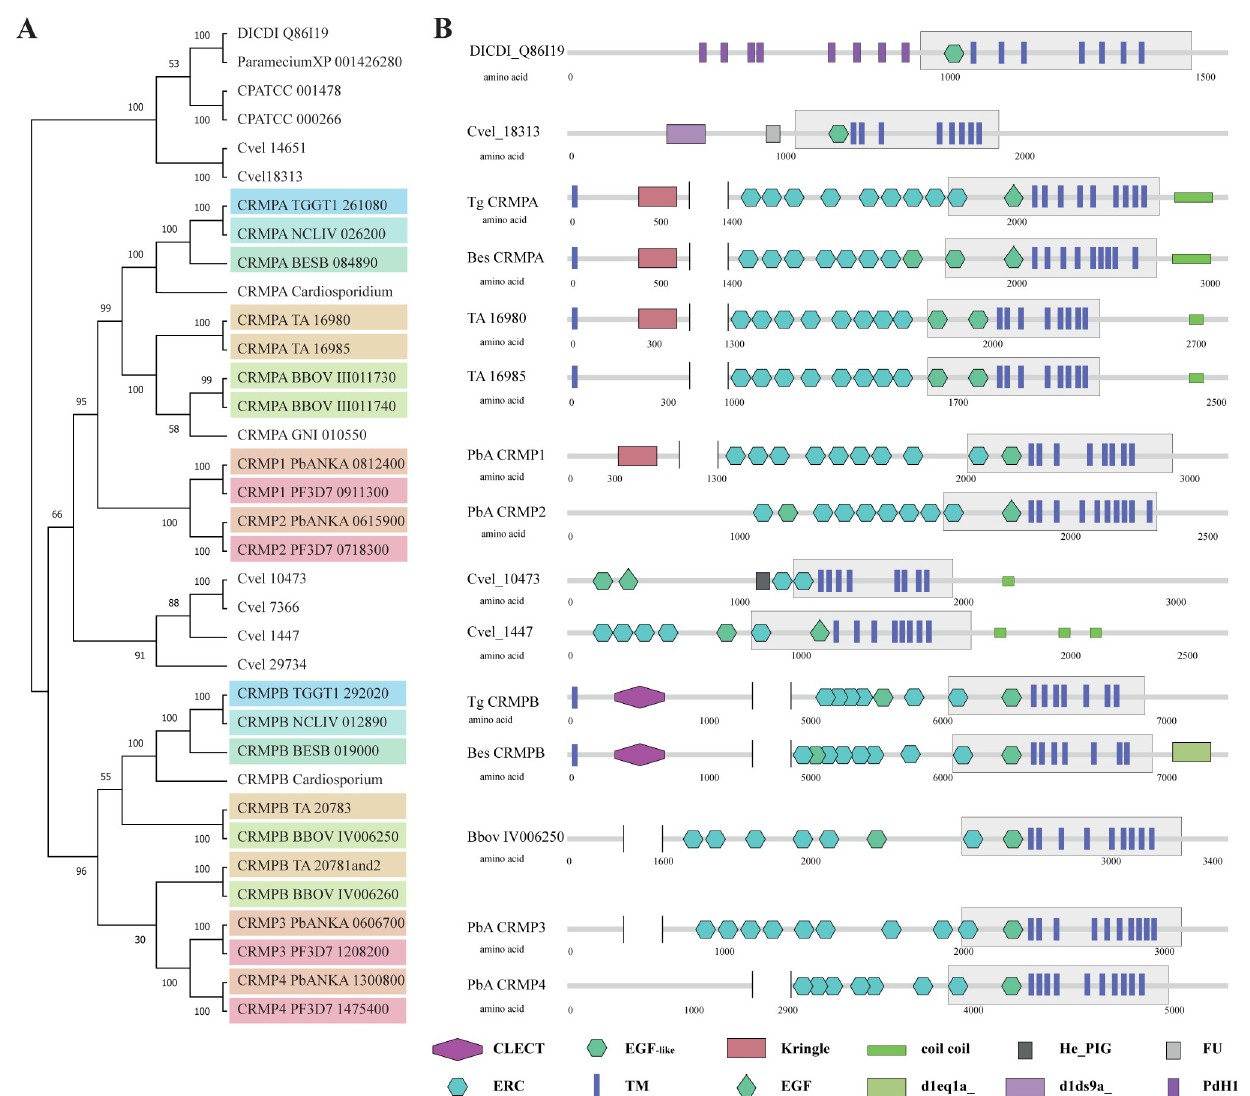
Fig 1. Phylogeny and domain architecture of Cysteine Repeat Modular Proteins. ( A) Phylogenetic relationship of CRMPs is shown after alignment of the entire coding sequence, bootstrap analysis (100 × ) supported most branches, colored by apicomplexan species. For sequences and alignment, see S1 Table. ( B) Domain architecture of selected CRMPs. Domains were predicted with SMART [36]. The conserved core containing the transmembrane domains was defined after the amino acid alignment and is indicated with a gray box. Some large N-terminal parts containing only internal repeats are not shown. Several domains are indicated: CLECT (c-type Lectin or carbohydrate recognition domain), ERC (Ephrin-receptor like), EGF-like (Epidermal growth factor-like), TM (transmembrane domain), Kringle (Kringle domain), EGF (Epidermal growth factor), coil coil (alpha helical coil coil domains), d1eq1a_ (apolipophorin III), He_PIG (putative Immunoglobulin-like fold), d1ds9a_ (outer arm of dynein light chain), FU (Furin-like repeats), PdH1 (parallel beta helix repeat). Additional data, see S1